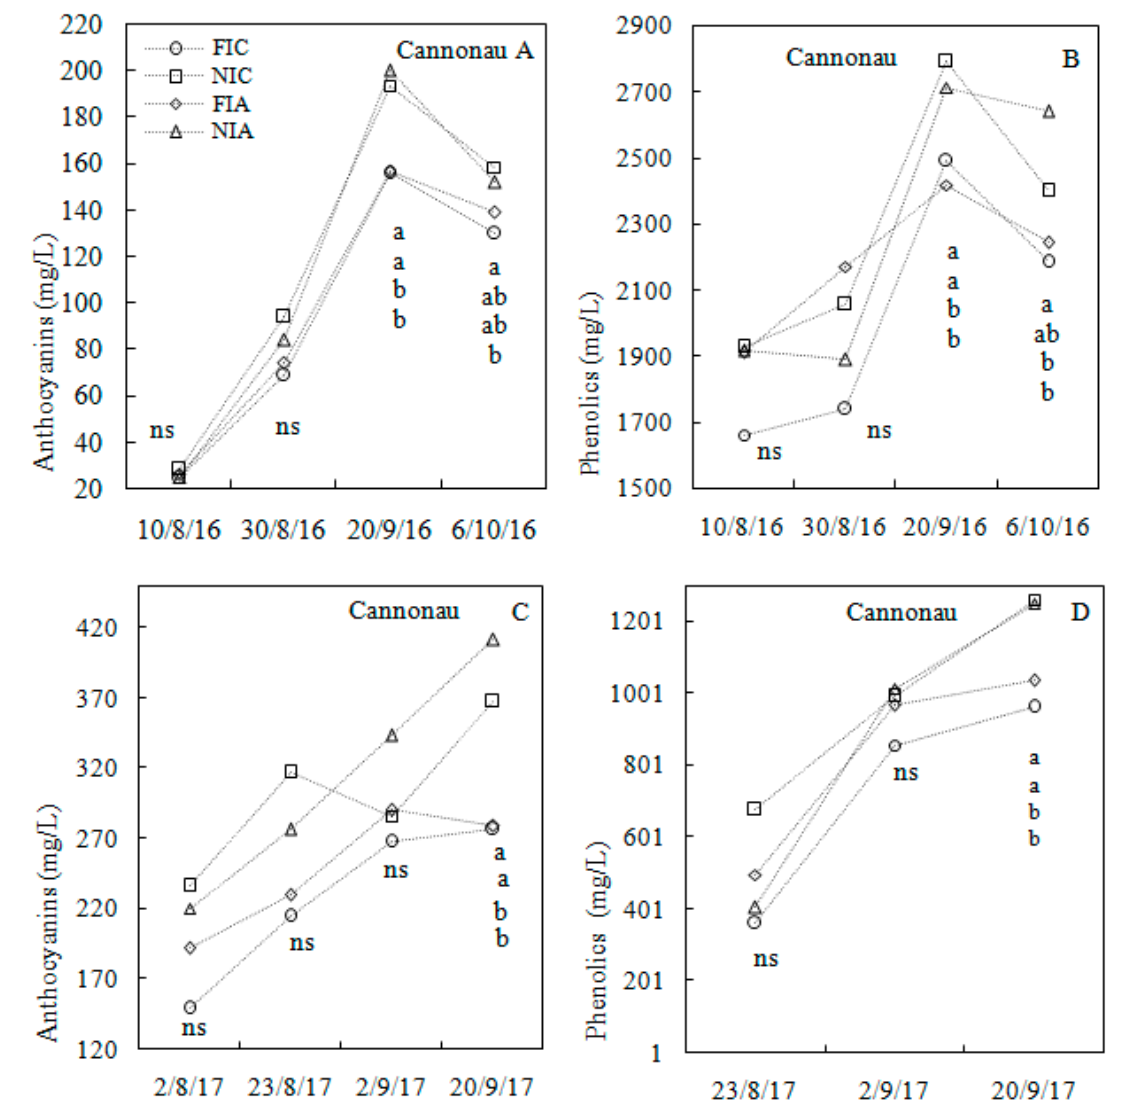
Figure 7. Seasonal variations of grape total anthocyanins in 2016 ( A ) and 2017 ( C ) and phenolics in 2016 ( B ) and 2017 ( D ) in cv. ‘Cannonau’. FIA = full irrigation ( + ) ABA; FIC = full irrigation ( − ) ABA; NIA = no irrigation ( + ) ABA NIC = no irrigation ( − ) ABA. The di ff erent letters indicate statistical significance at P ≤ 0.05 using the LSD test. ns = not significant.